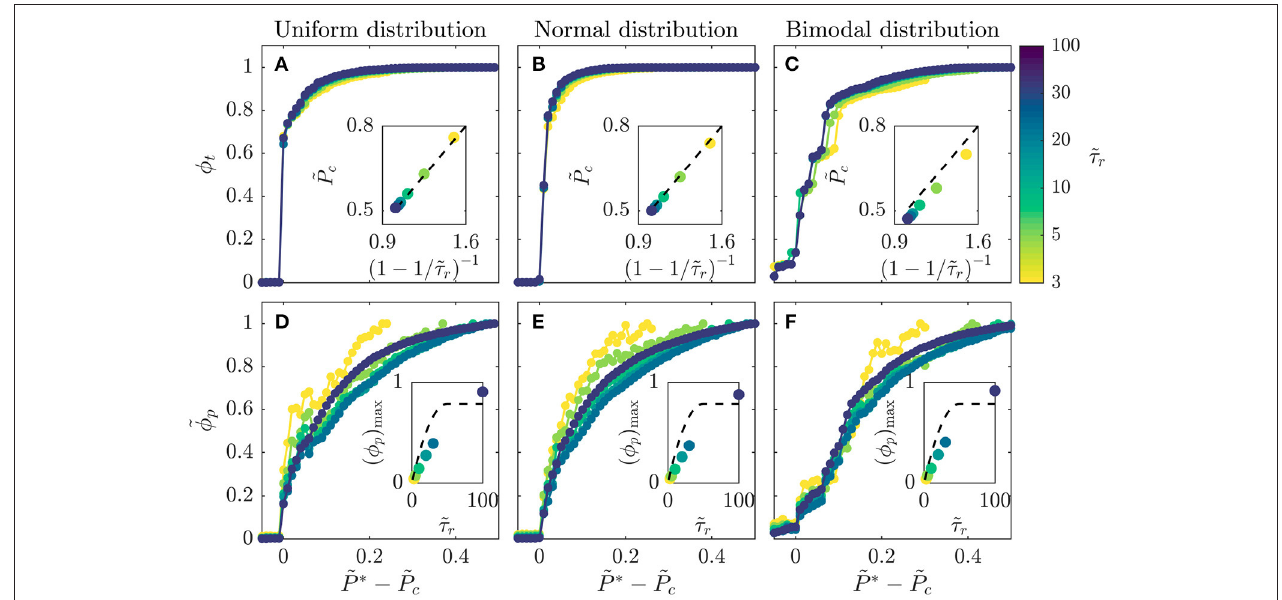
FIGURE 3 | Amount of infection shows a general dependence on disease infectivity across populations with different recovery durations and distributions of individual P c ; insets show that the critical interaction barriers. (A–C) Data for the total infected fraction φ t align when plotted as a function of the shifted disease infectivity ˜ P ∗ − ˜ φ p / ( φ p ) max show reasonable alignment when infectivity ˜ P c is given by the relation in Equation (1) (dashed lines). (D–F) Data for the rescaled peak infected fraction ˜ φ p ≡ P c ; insets show that the theoretical φ ( τ p ) calculated using Equation (2) (dashed lines) provides a reasonable plotted as a function of the shifted disease infectivity ˜ P ∗ − ˜ ˜ τ r increases. All three approximation to the maximal peak fraction ( φ p ) max determined for ˜ P ∗ 2. Intriguingly, all the datasets appear to approximately converge as = ˜ distributions span ˜ P th, ij [0,1]; the normal distribution is centered at 0.5 and has standard deviation = 0.25, while the bimodal is constructed from two normal ∈ distributions centered at 0 and 1, both with standard deviation = 0.25. Each point represents a separate simulation, all of which preserve the same lattice network τ r , enabling us to systematically test the influence of these two key parameters on disease structure of the ˜ P th, ij for a given distribution and only vary ˜ P ∗ and ˜